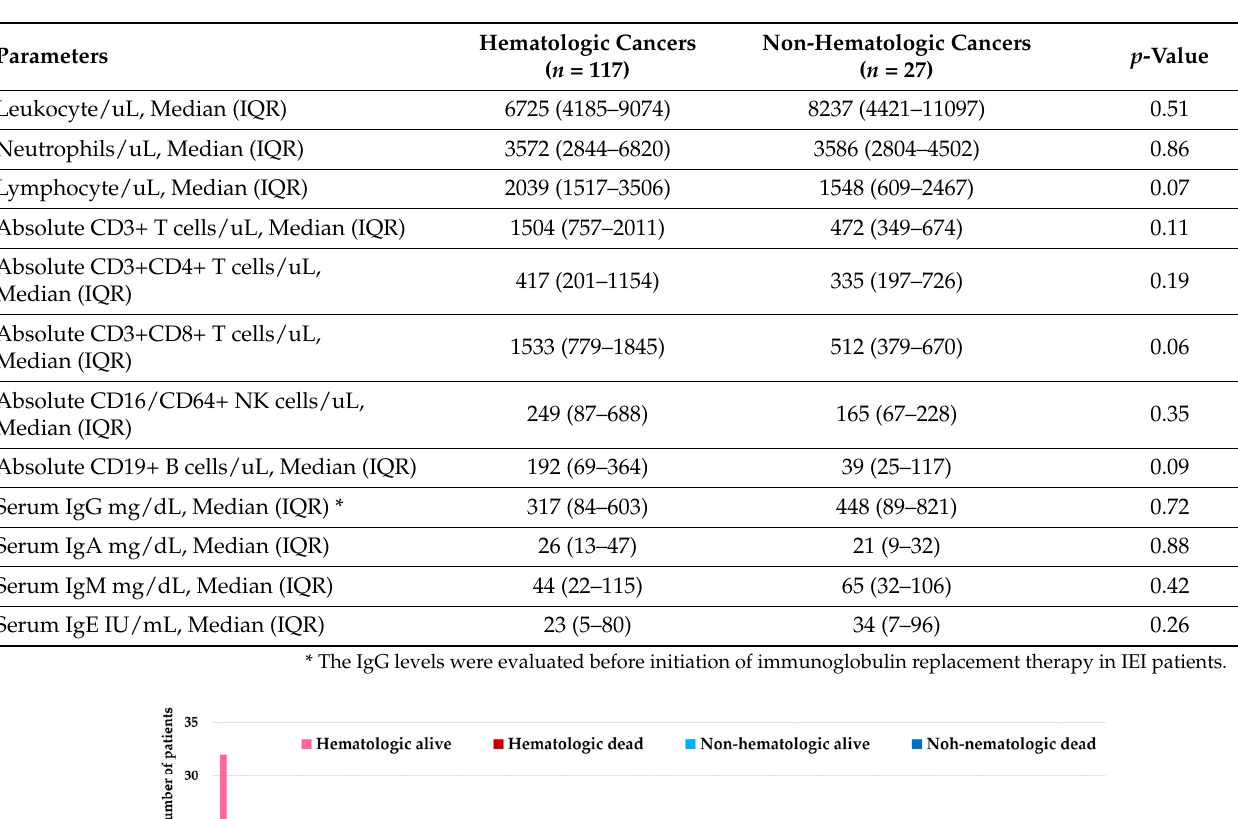
Table 2. Immunologic profiling of IEI patients with non-hematologic and hematologic tumors at the time of IEI diagnosis.